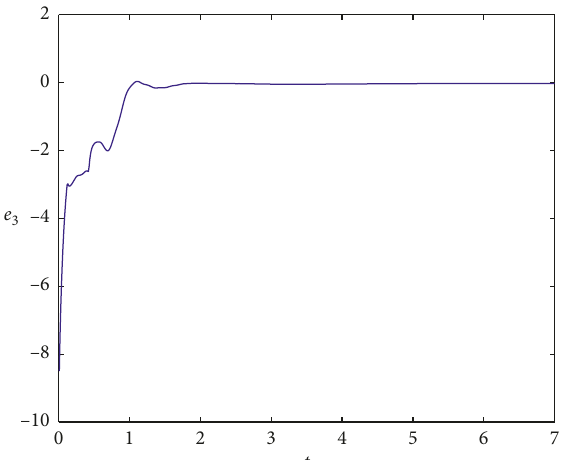
Figure 6: Combination synchronization errors e systems (20) and (23) and response system (26).